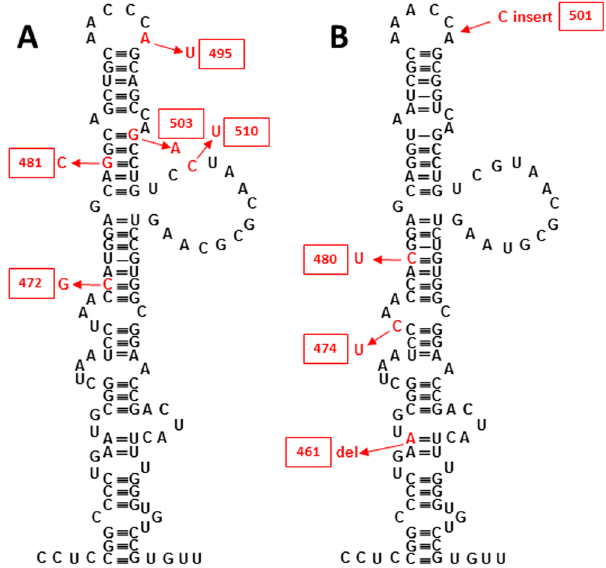
Figure 4. Secondary structure of the IRES element domain V from PPS cases RBJ/va15 ( A ) and LZL/va10 ( B ). Hairpin structures are presented in black for viruses that are most closely related to the PCR product sequences from respective cases. Mutations in the sequences from PPS cases are shown in red. In most cases these mutations disrupt the secondary structure of domain V, suggesting that the mutated agents have reduced